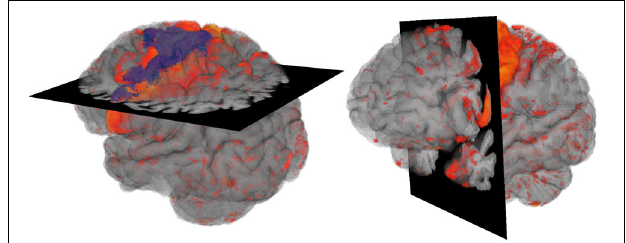
FIGURE 1 | Overview Design: Volume visualization showing brain degeneration (yellow/red) and the premotor cortex area (blue) in anatomical context